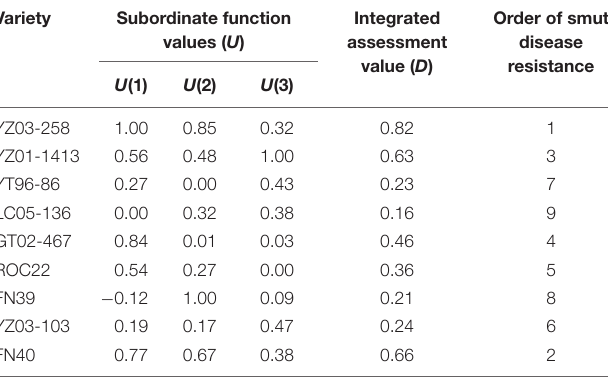
TABLE 5 | Subordinate function values of principal component and comprehensive evaluation of smut disease resistance in different sugarcane varieties under Sporisorium scitamineum